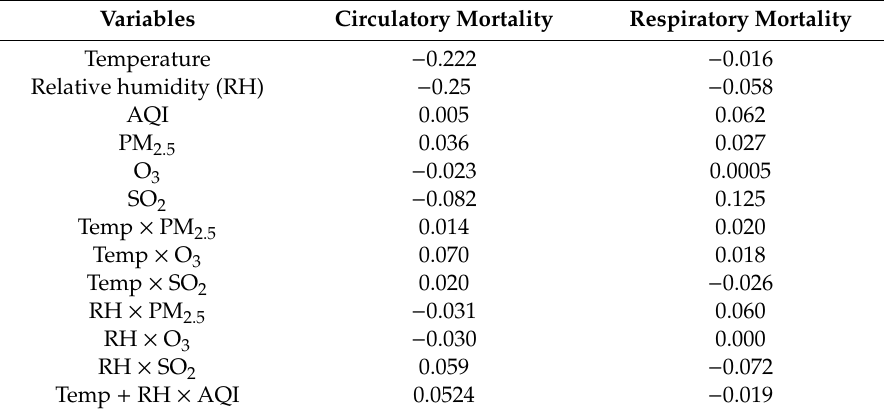
Table 5. Coe ffi cients of interaction between climatic factors and air pollution in relation to circulatory and respiratory mortality.